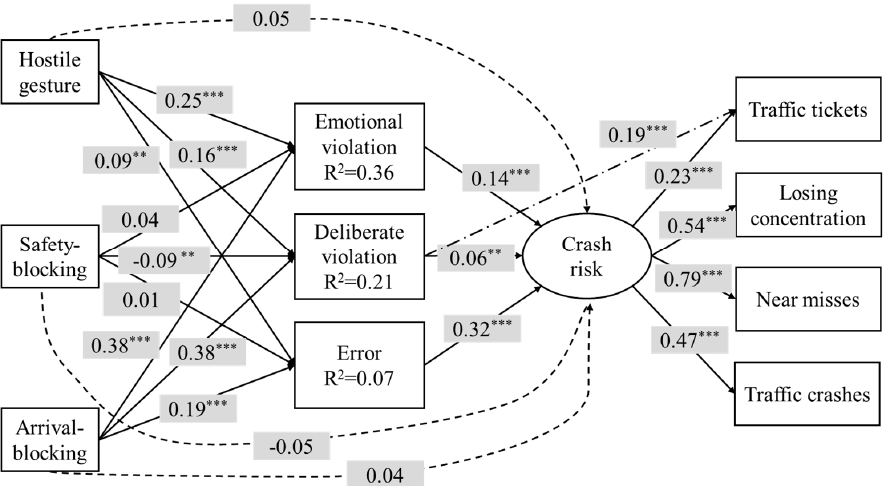
Figure 2. Results of the mediated model. Values on the paths are the standardized path coefficients. The dashed lines represent the direct effects of driving anger on crash risk and the dash-dot line represents the direct effect of deliberate violation on traffic tickets. R 2 represents the amount of variance the factor is accounted for in the model. ** p < 0.01; *** p <